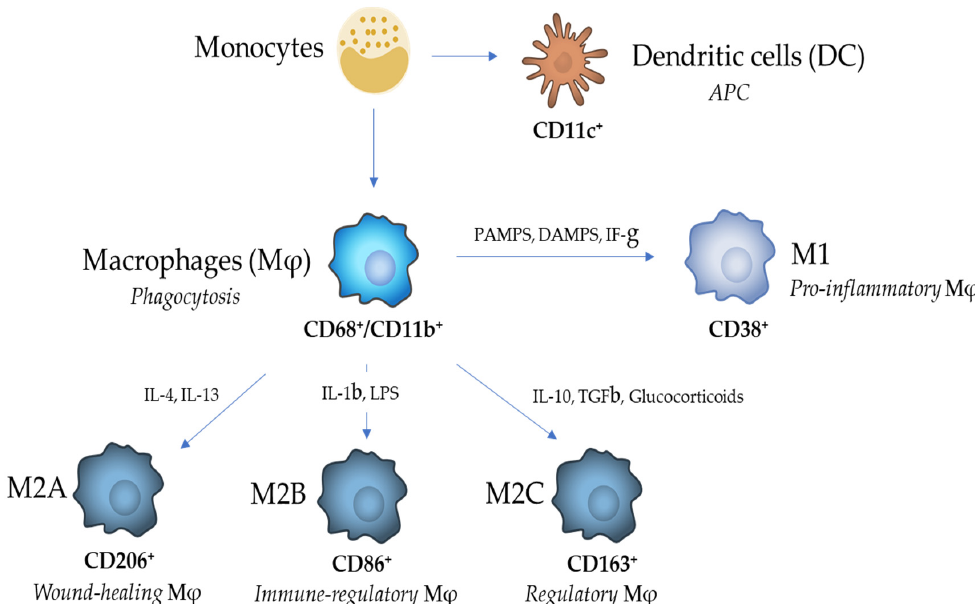
Figure 1. Schematic representation of the monocytic/macrophage differentiation lineage with related markers and cellular functions.